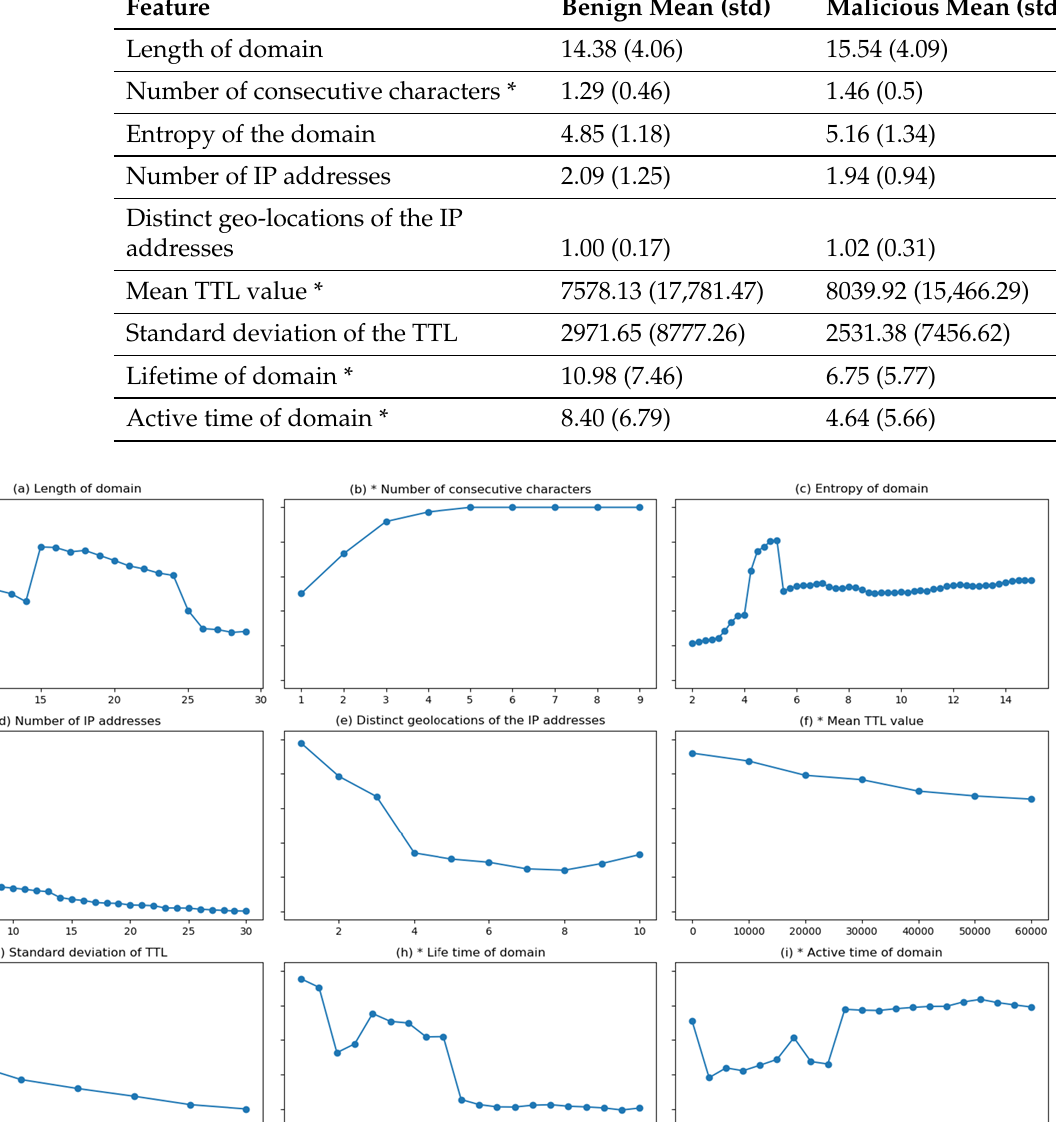
Table 2. Classic features and statistical properties (*—robust features).